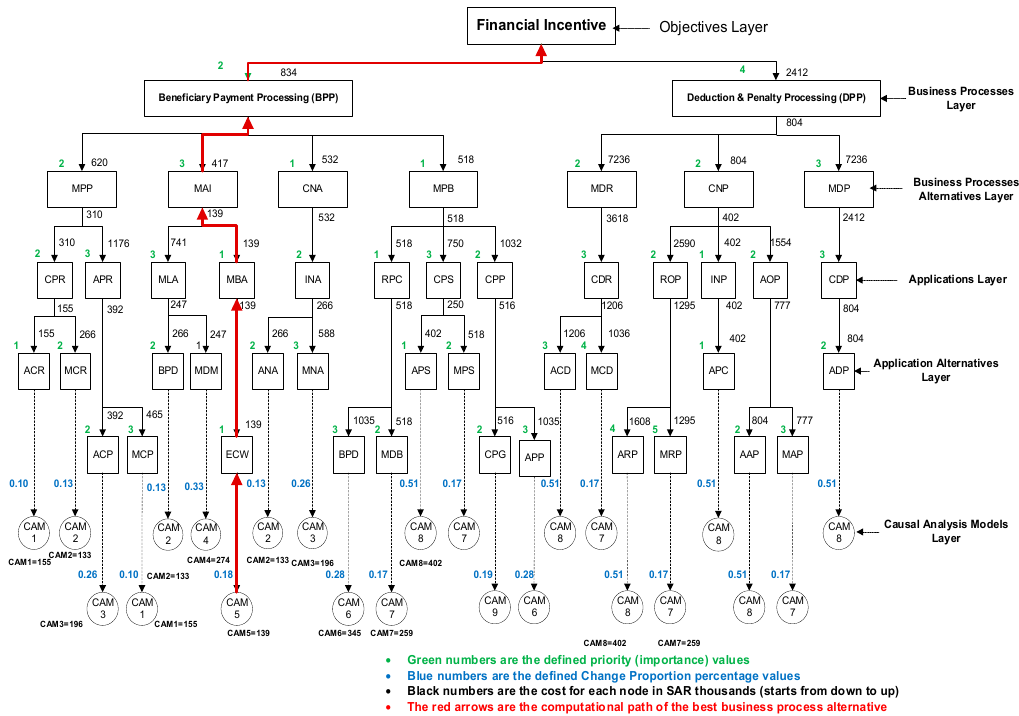
Figure A4. Hierarchical Change Management Structure Computational Framework (Alrabiah and Drew 2018b).